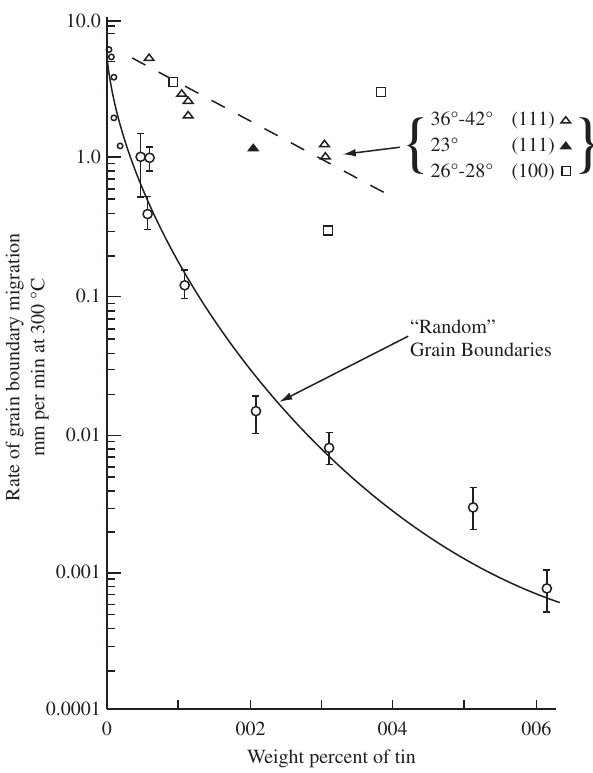
Figure 10. Changes on migration rate of grain boundaries of lead at 300 °C as a function of tin content, for random grain boundaries and special grain boundaries 87,88